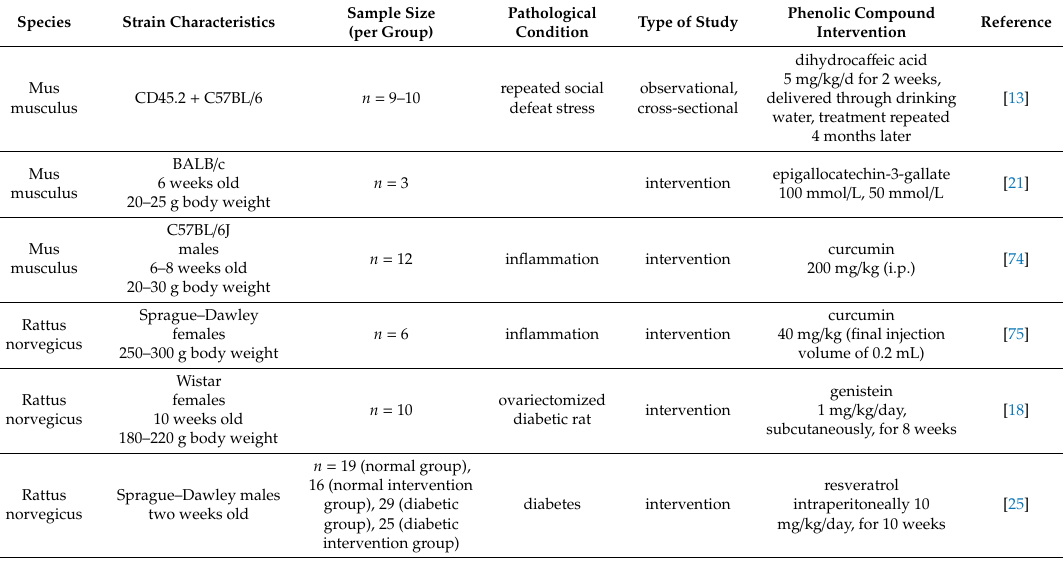
Table 2. Summary of the studies performed on animal models.